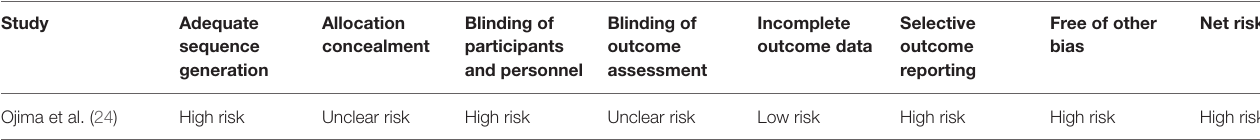
TABLE 3 | Quality assessment of clinical trials using Cochrane Collaboration’s risk of bias